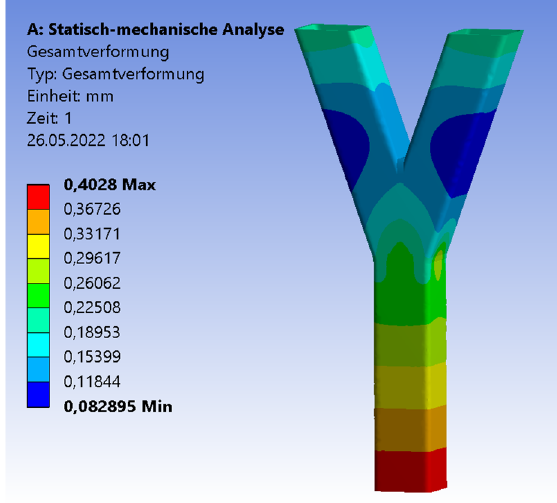
Figure 7. Boundary conditions. Numerical model.